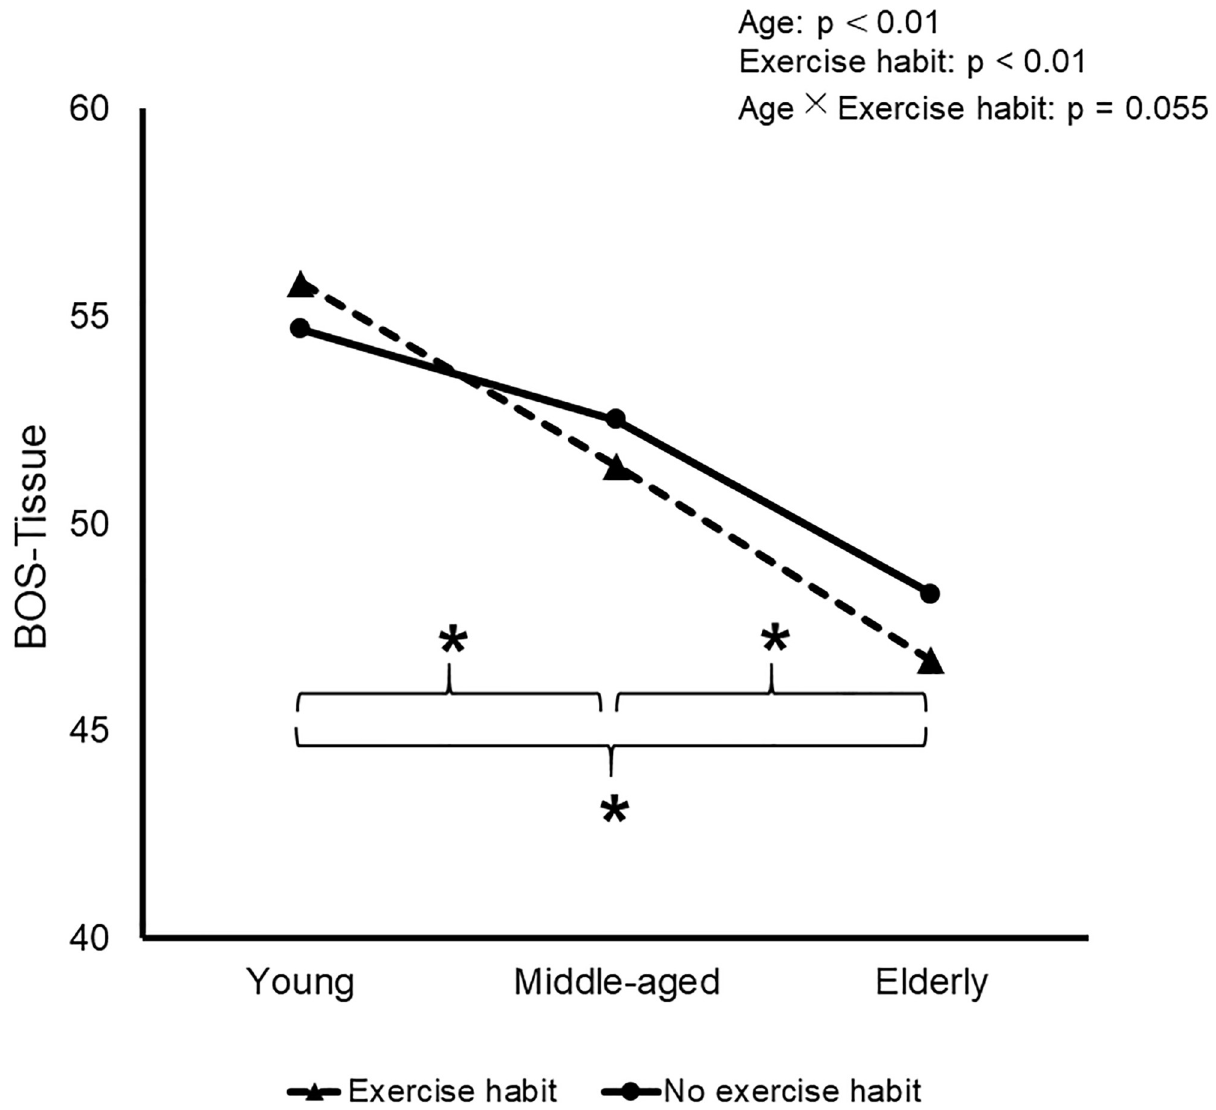
Fig 3. Effects of aging and MHLW-based exercise habits on BOS-Tissue. � , significant difference among young ( < 40 years old), middle-aged (41–64) and elderly ( > 65) groups with and without exercise habits. Data are mean and SD.